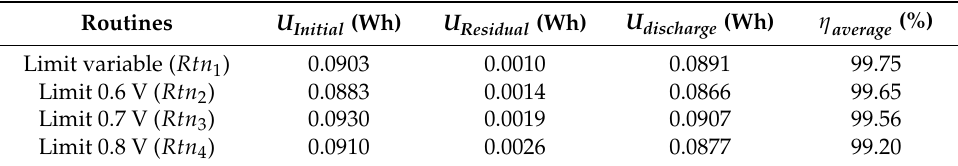
Table 4. Calculated efficiency of the bank changeover circuit in all configuration